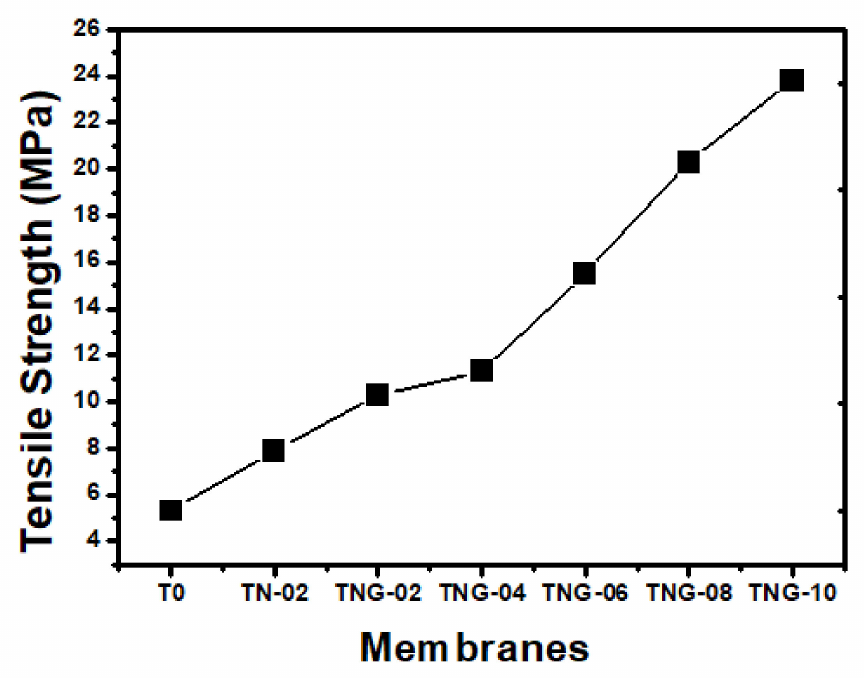
Figure 4. Comparison of tensile strength of the as-prepared